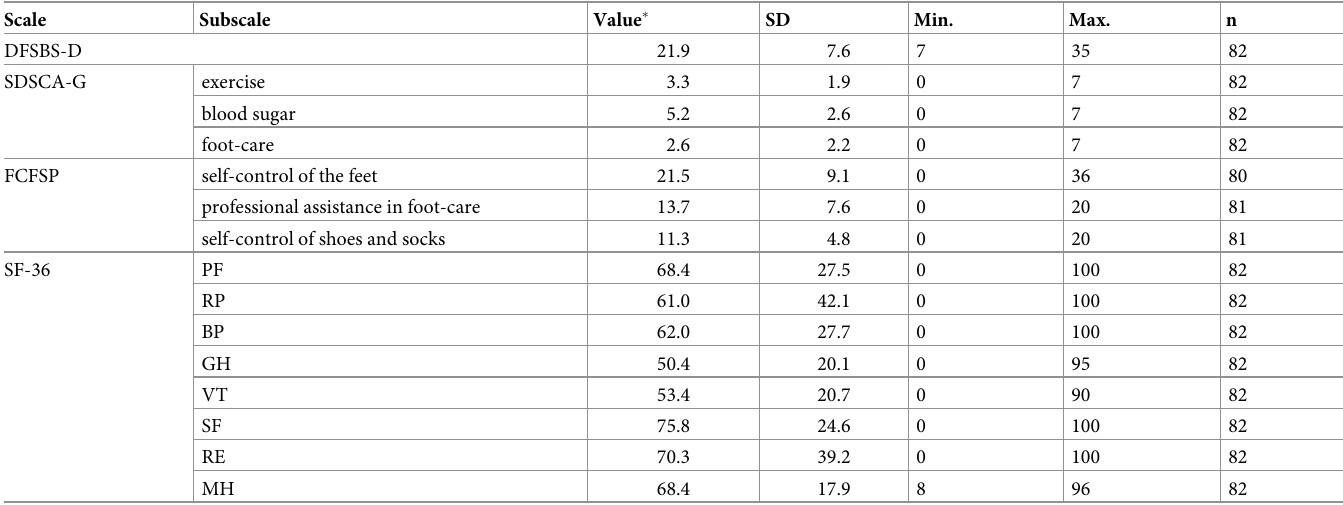
� values are mean or sum scores Abbreviations: DFSBS-D, German version of the Diabetic Foot Self-care Behavior Scale; FCFSP, Frankfurter Catalogue of Foot Self-Care-Prevention of the